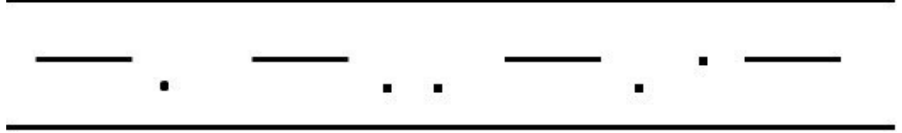
Figure 1 - F0 movement in the head of an IP of the HKE